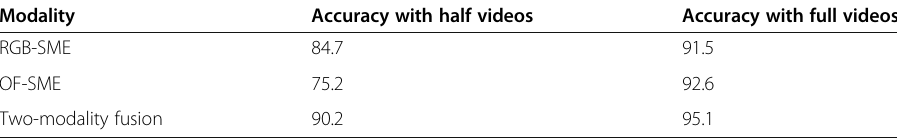
Table 2 Prediction accuracy comparison of different modalities on UT-Interaction set 2 (%) Modality